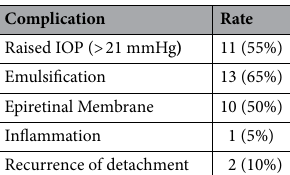
Table 1. The frequency of complications in patients with long-term heavy silicone oil implantation after primary PPV